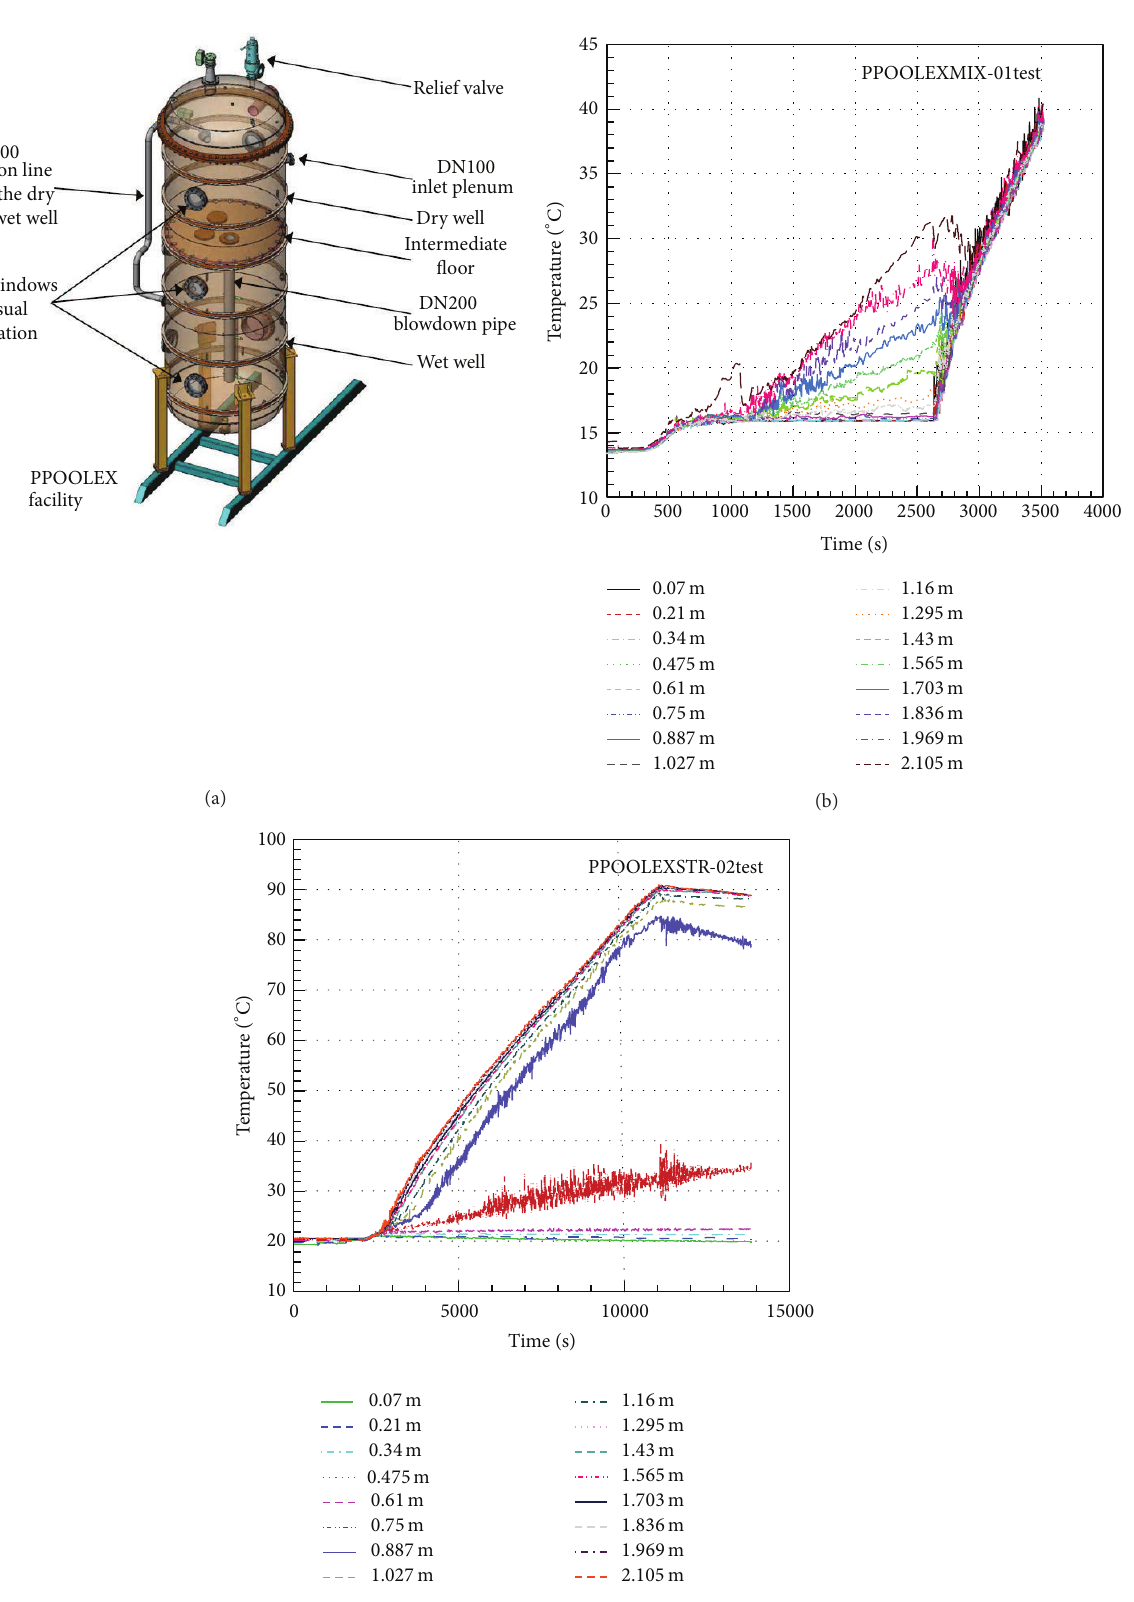
Figure 3: (a) PPOOLEX experiment facility and examples of (b) thermal stratification development during the MIX-01 test and (c) existence of a thermocline layer during the STR-02 test [12,